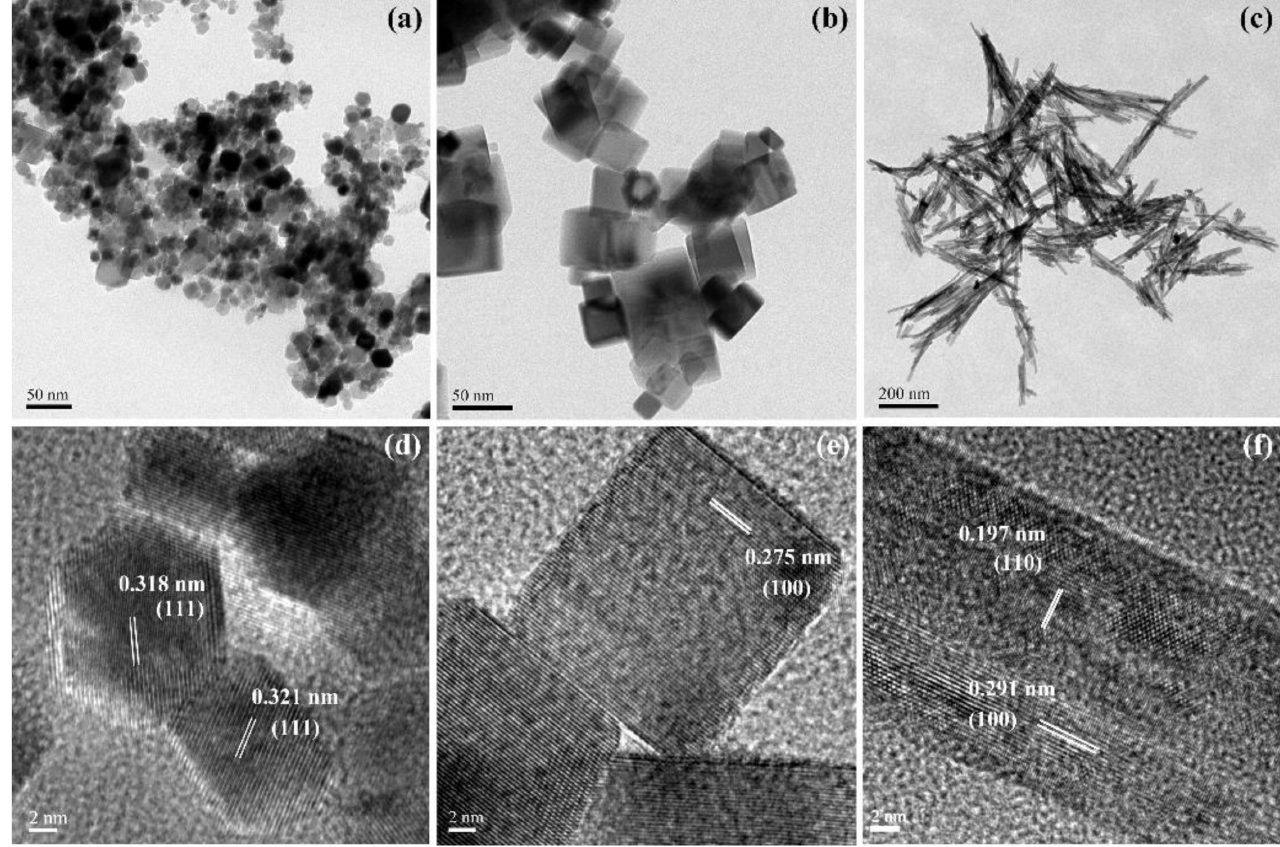
Figure 2. TEM images of raw P-CeO 2 ( a ), C-CeO 2 ( b ) and R-CeO 2 ( c ), HRTEM images of raw P-CeO 2 ( d ), C-CeO 2 ( e ) and R-CeO 2 ( f